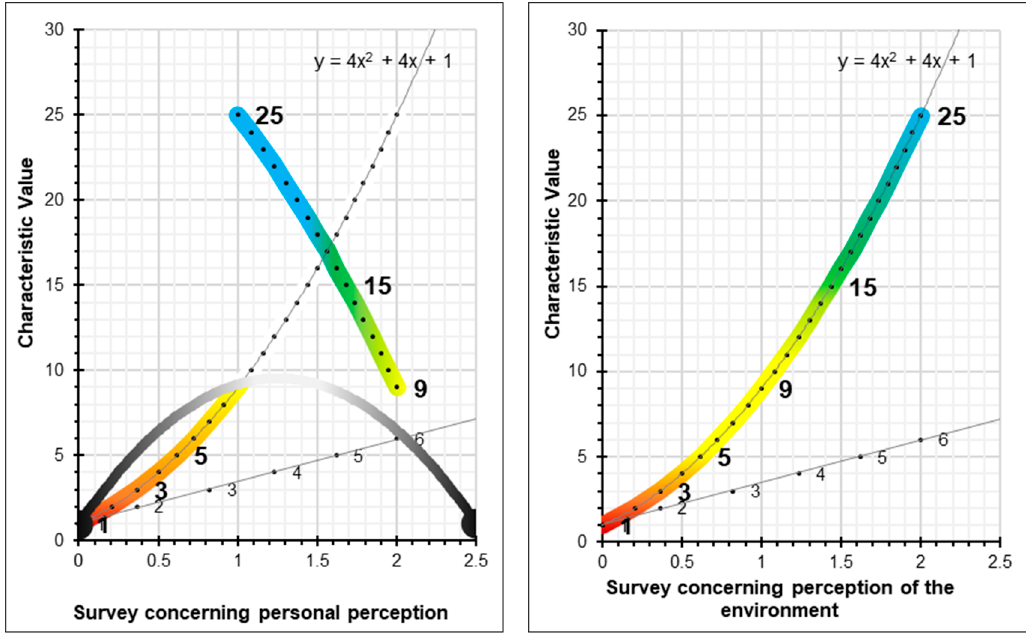
Figure 9. Graphical representation of responses using the characteristic values. Int. J. Environ. Res. Public Health 2020 , 17 , x FOR PEER REVIEW